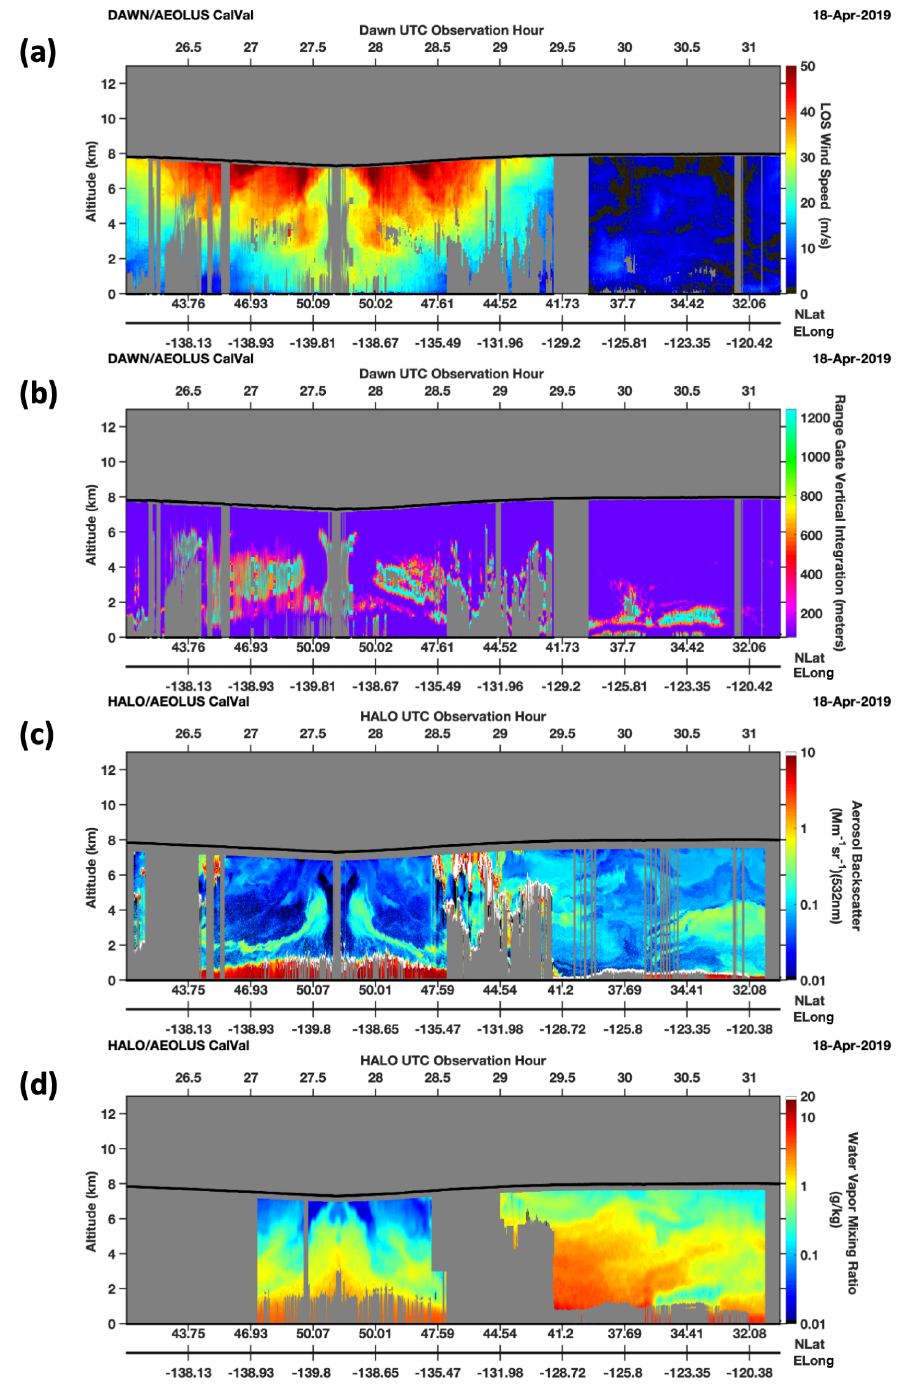
Figure 3. (a) The absolute value of the DAWN horizontal line of sight (HLOS) wind speed measurement, projected 90 ◦ to the right of the aircraft heading from 02:00 to 07:15UTC (i.e., 26–31.25 above) on 18 April 2019. The bold black line atop the colored cross section indicates the DC-8 flight altitude. (b) The depth of the vertical signal integration required to achieve sufficient signal for a DAWN wind retrieval. (c) HALO 532nm aerosol backscatter coefficient, shown with a logarithmic color scale to accentuate variations in the free troposphere aerosol distributions. (d) HALO WVMR also shown with a logarithmic color scale. Gray areas in the DAWN and HALO cross sections indicate aircraft turns (roll ≥ 2 . 5 ◦ ), areas beneath opaque cloud cover, inadequate signal return inhibiting retrieval at a particular altitude, or instrument